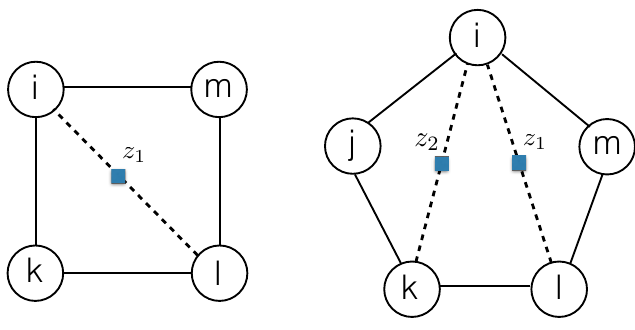
Figure 2 . The one- and two-particle length zero contributions. The blue squares denote the mirror particles and the cross-ratios z 1 and z 2 are de(cid:12)ned in (2.3). The bridges connecting the operators (solid lines) have non-zero bridge-lengths. At two-loops, there are two relevant types of one-particle contributions, one if the bridge length is zero as shown in the (cid:12)gure and the other if the brigde has length one. Similarly, there are three types of two-particle contributions depending on the bridge lengths, see